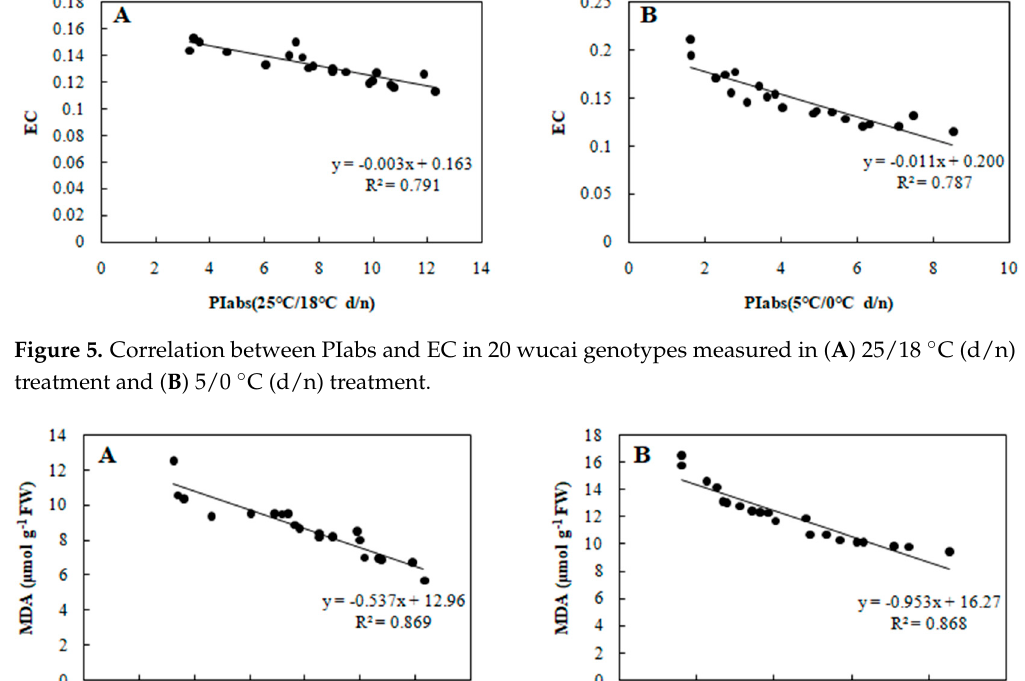
Figure 4. Correlation between PIabs and SLA in 20 wucai genotypes measured in ( A ) 25/18 °C (d/n) treatment and ( B ) 5/0 °C (d/n) treatment.